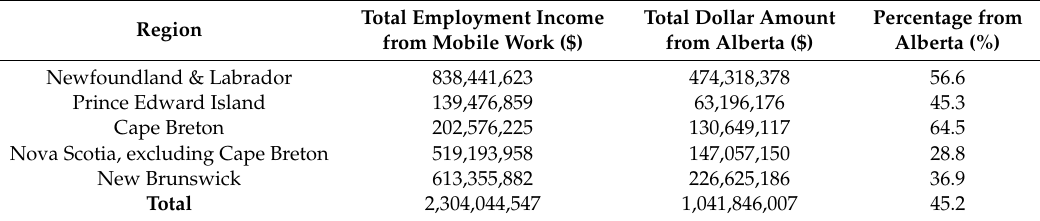
Table 3. Total employment income from mobile work, 2011.